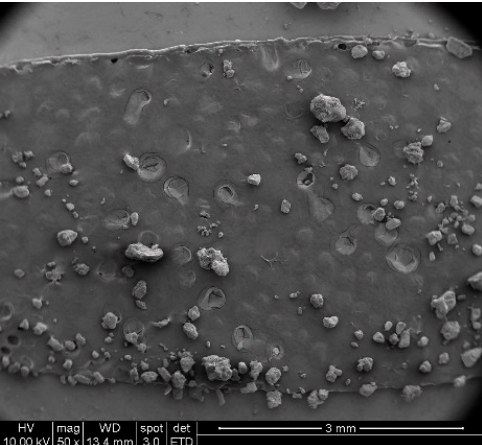
Figure 4. SEM image of ST (50×).